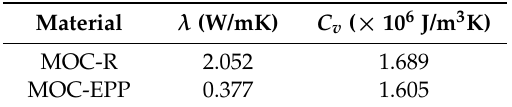
Table 7. Thermal conductivity and volumetric heat capacity of MOC composites.